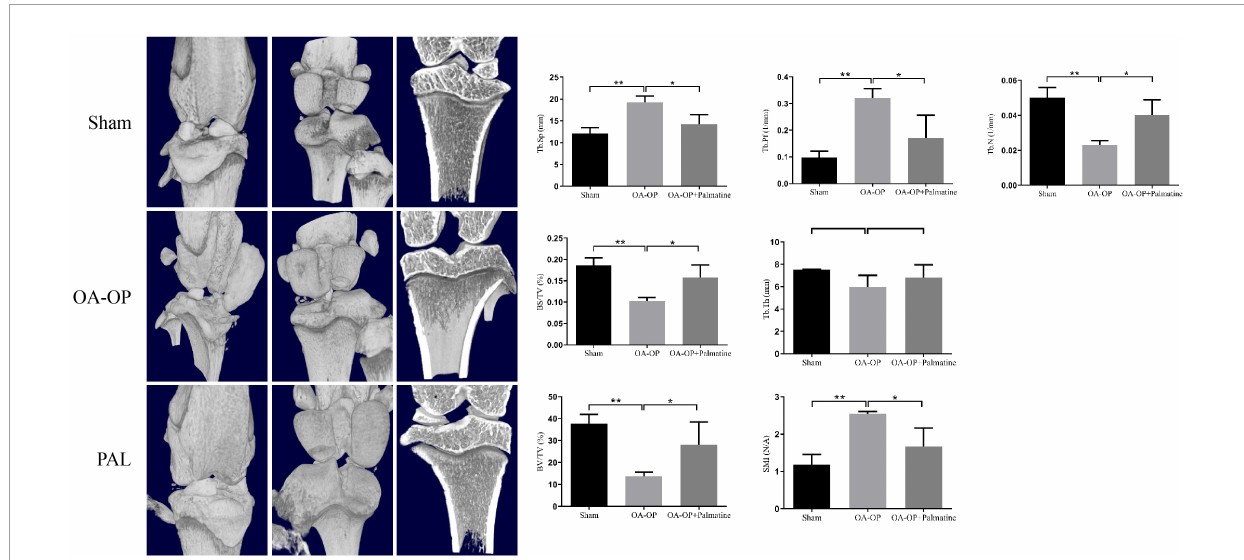
FIGURE2 Effect of PAL on bone trabecular morphometric parameters in OA-OP rats. Micro-CT images of the distal femur and proximal tibia 56 days after PAL administration; Tb. N, BV/TV, BS/TV, Tb. Th, Tb. Pf, Tb. Sp, and SMI, 56 days after PAL administration Micro-CT analysis. *Statistically significant difference ( P < 0.05). **Statistically significant difference ( P <